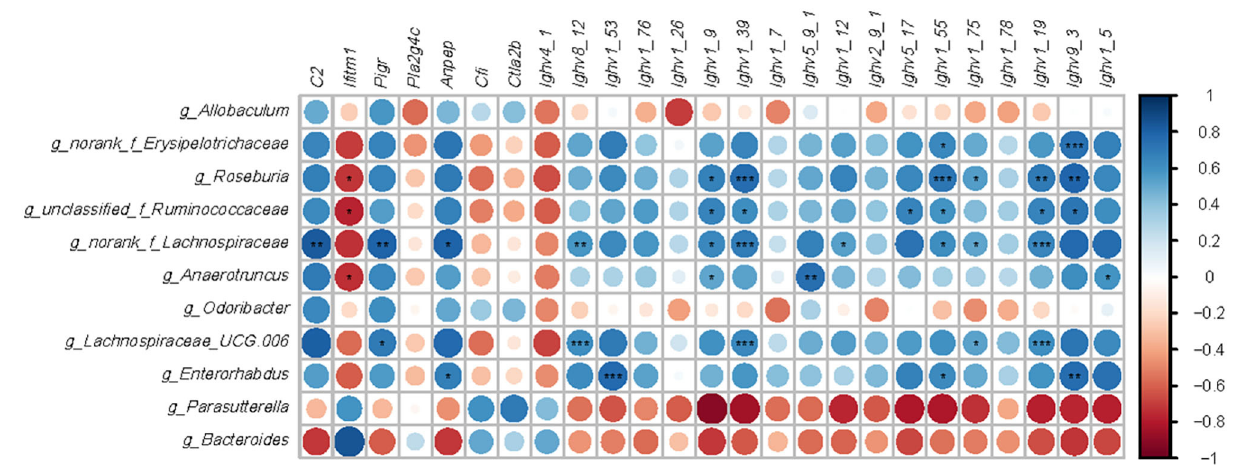
Frontiers in Nutrition |